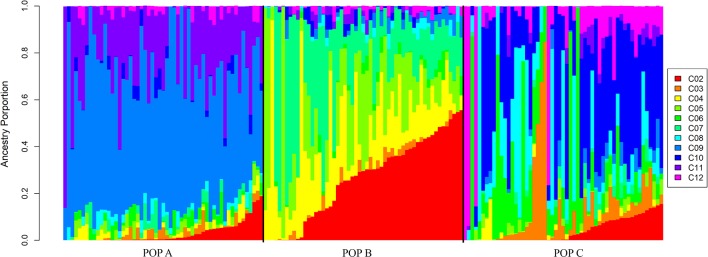
Admixture clustering of the three Nile population for K = 11. The animals are grouped by population and each individual is represented by a vertical bar. The gradient black lines delineate different populations under study and each color represent a different cluster ranged from 2 to 12 (C02 to C12).